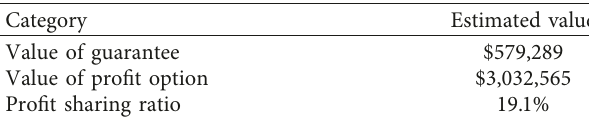
Table 6: Profit sharing ratio.